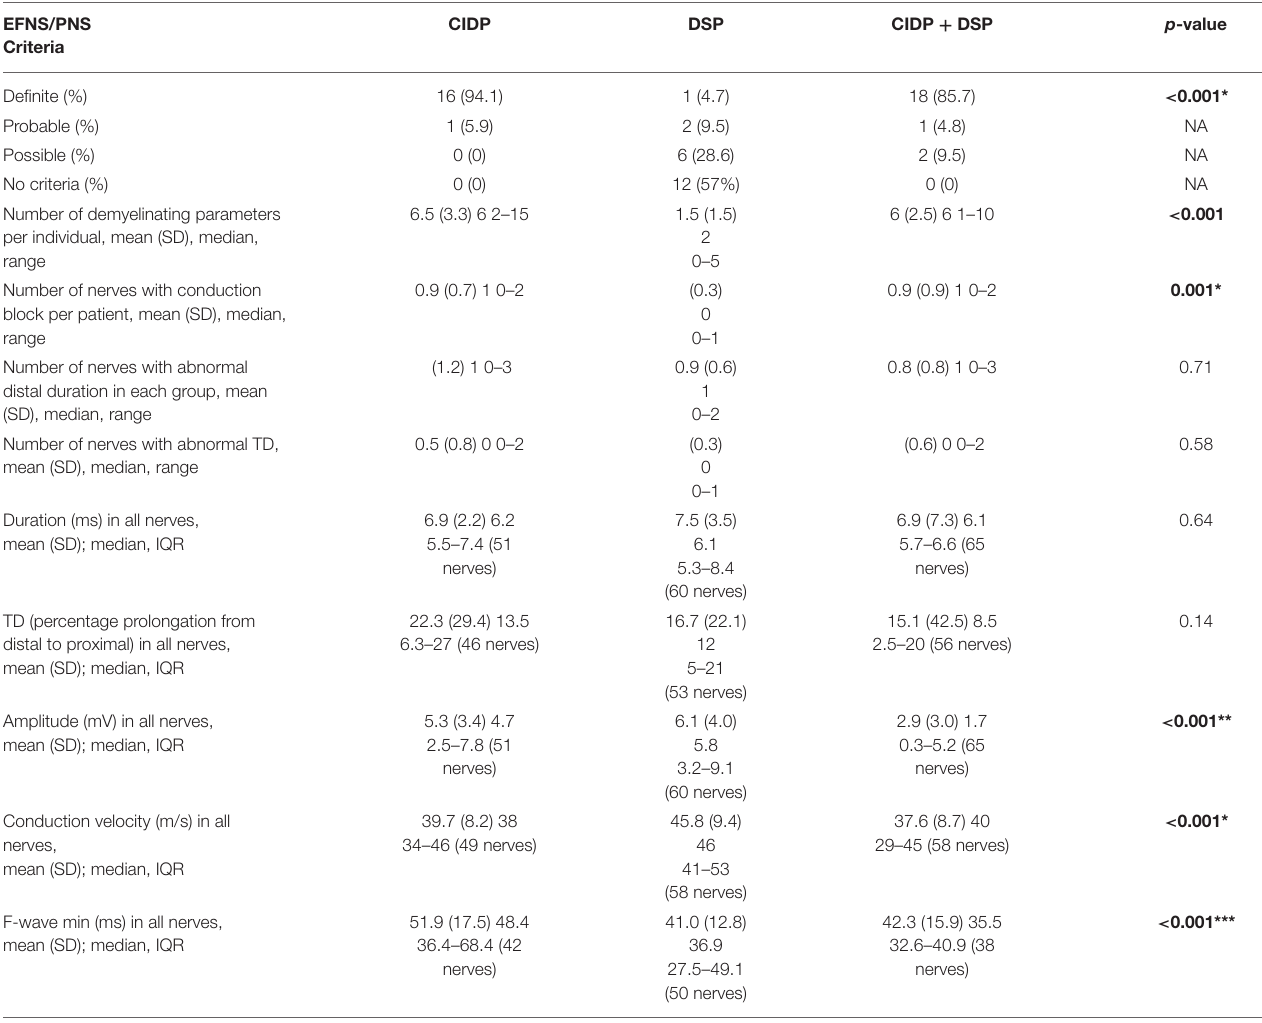
TABLE 2 | Electrophysiologic criteria. EFNS/PNS Criteria